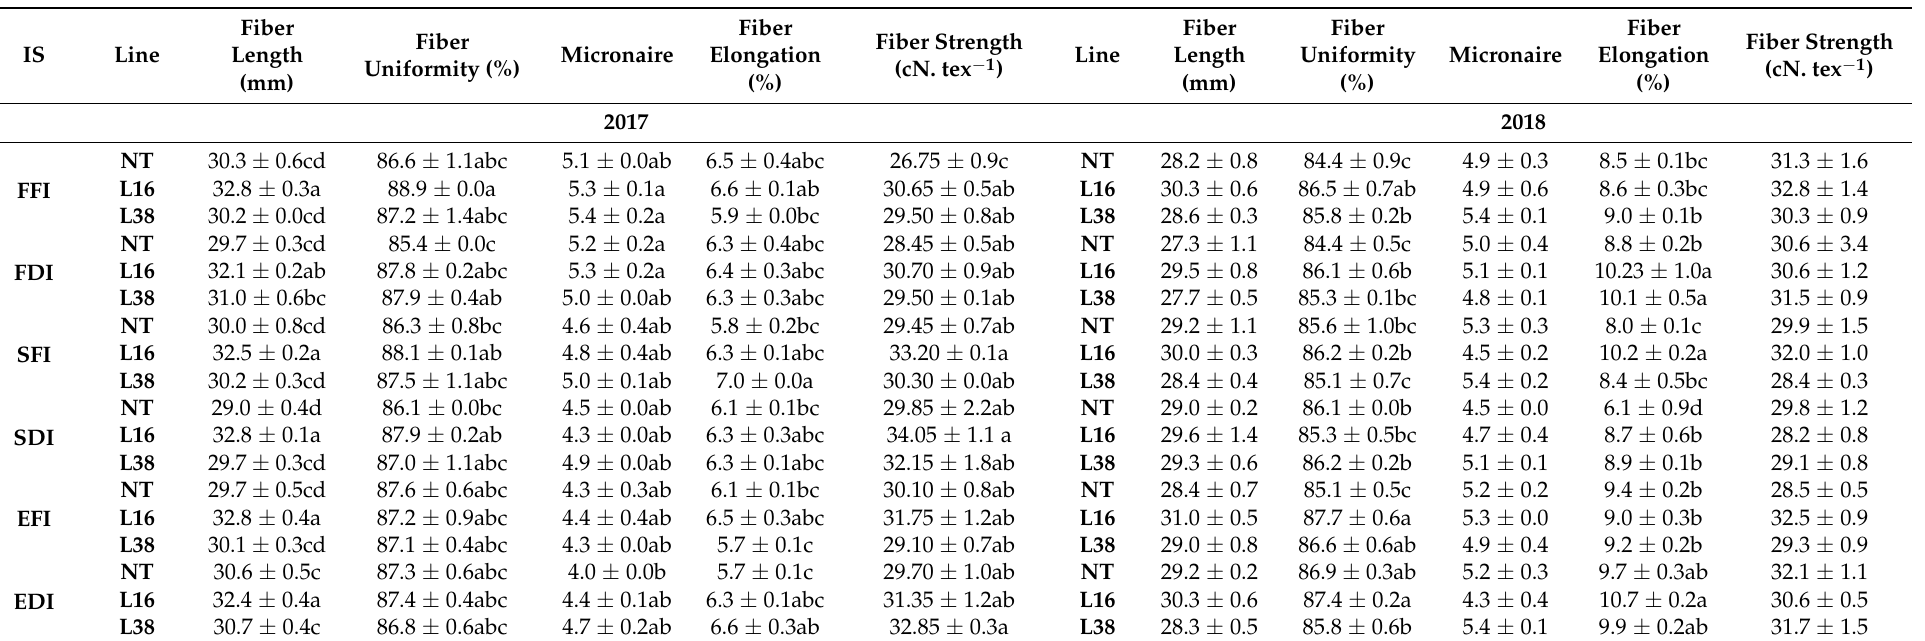
Table 4. Fiber quality parameters under different irrigation treatments in 2017 and